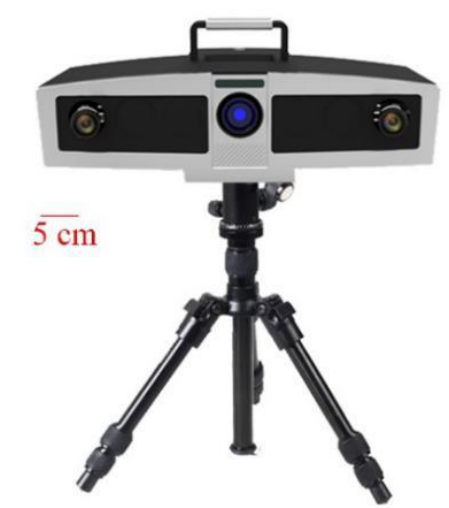
Figure 7. Three-dimensional scanner.